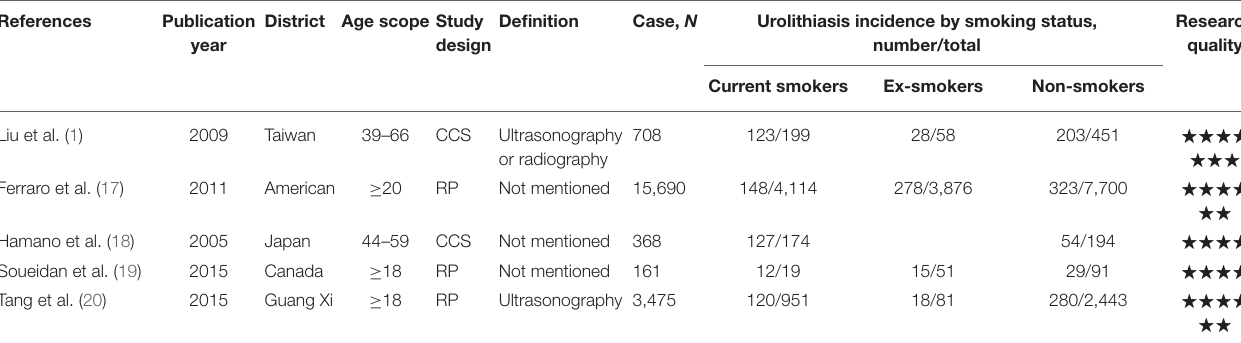
TABLE 1 | Included